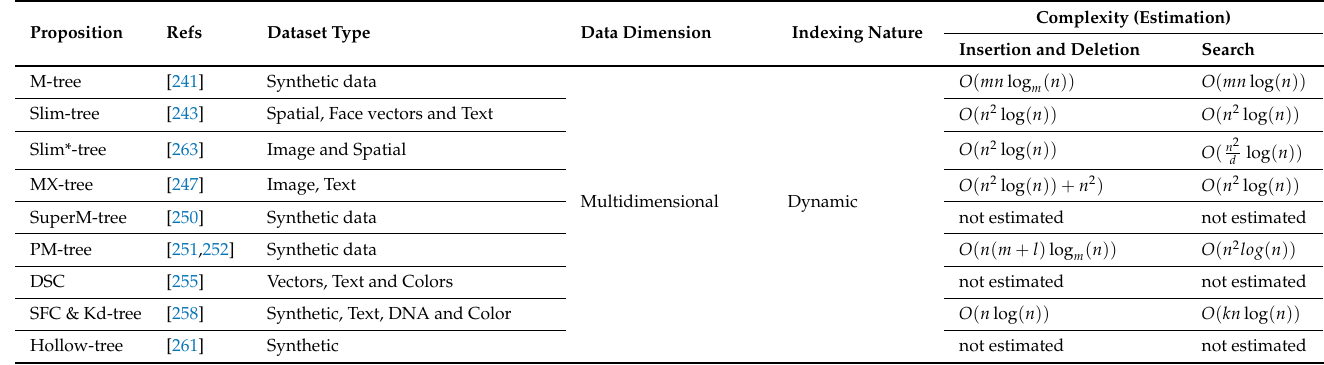
Table 15. Analysis of metric indexing techniques based on data partitioning.